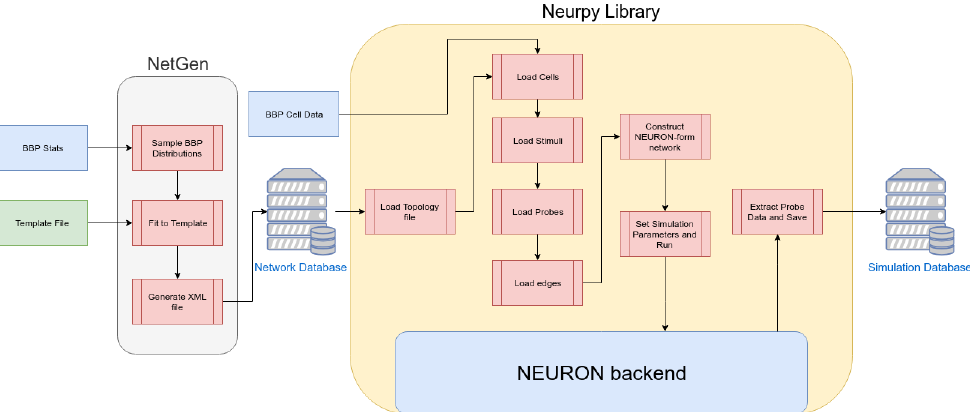
Figure 2. Structure of experimental environment: network (topology) generation, cell information input and